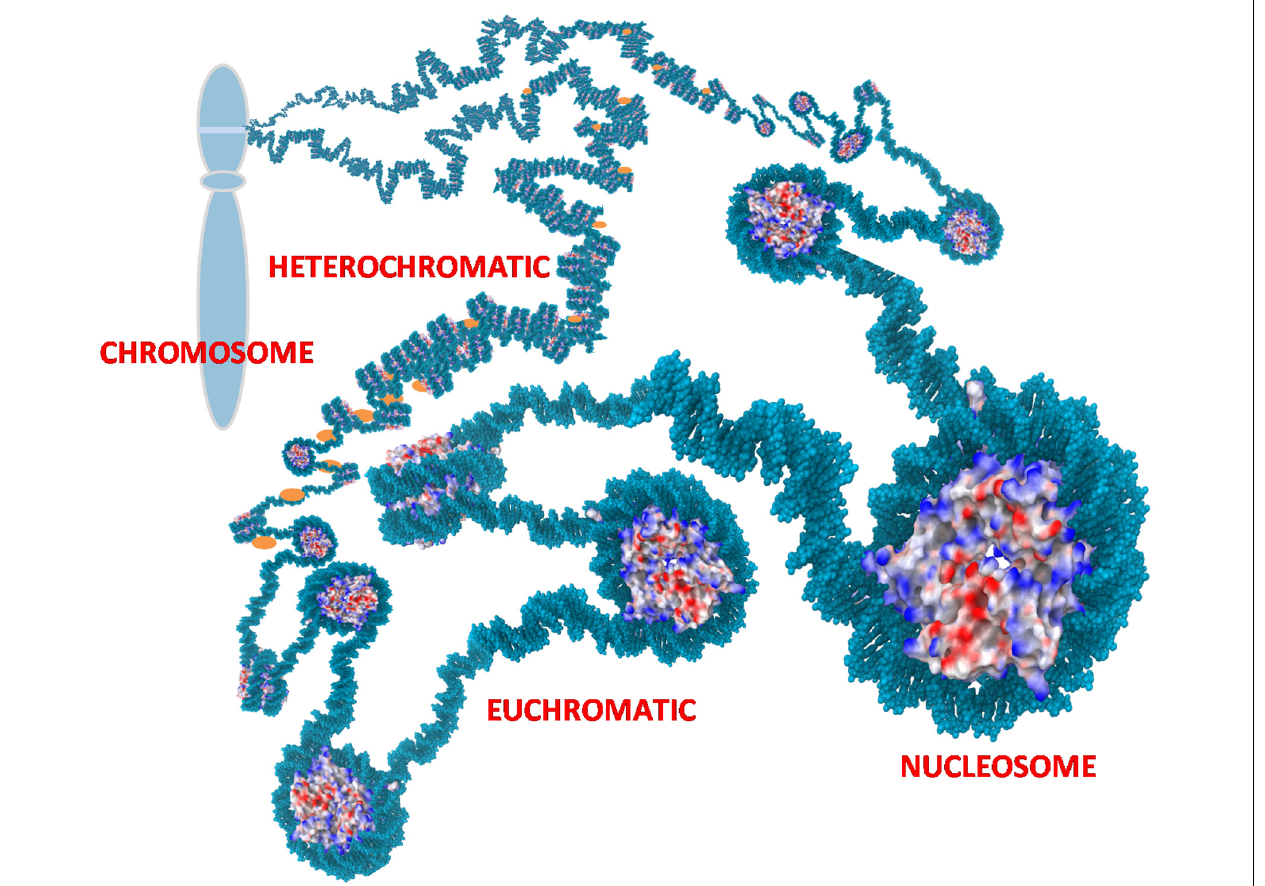
allows access to the underlying genes. Heterochromatin is a condensed form with histone H1 (orange) bound to the linker DNA between nucleosomes. This can compact the chromatin further and sequesters the underlying genes. The chromatin is further organized into loops that are usually tightly coiled and stacked into chromosomes but the loops can rapidly uncoil into extended states as depicted to allow access to sequestered